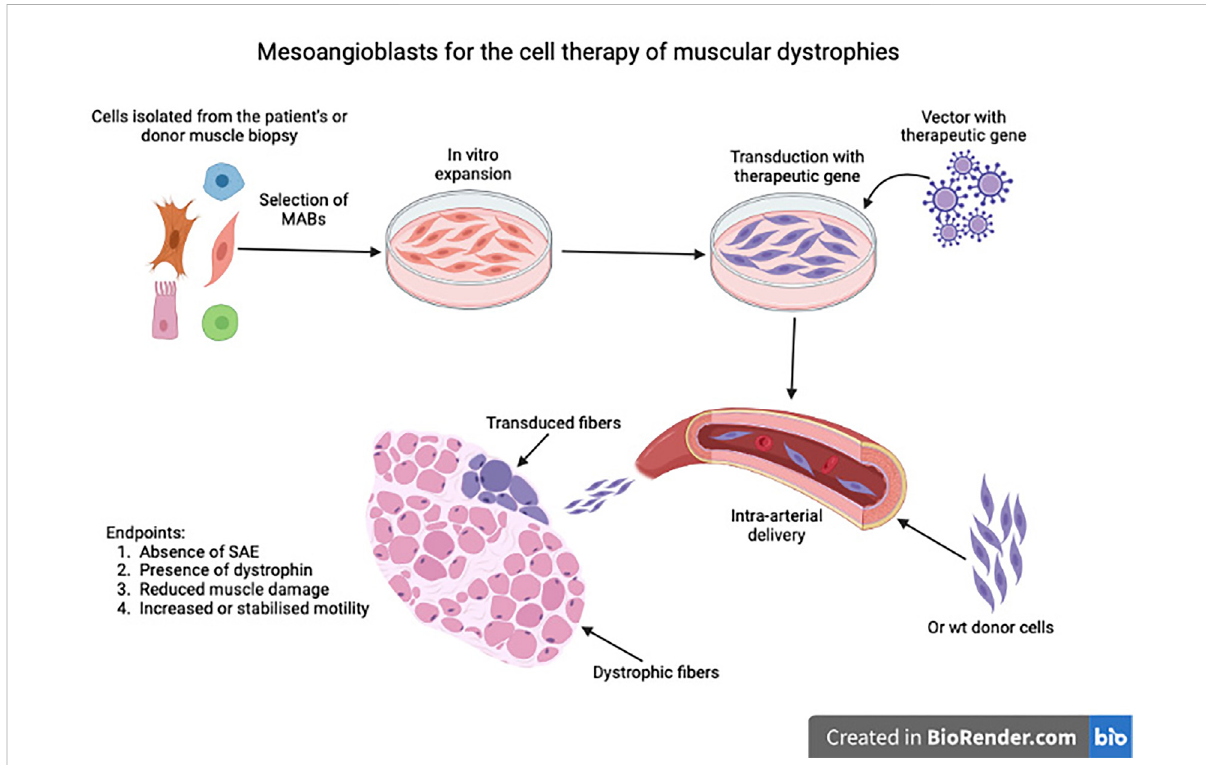
FIGURE 5 Schematic representation of the process leading to isolation, expansion, eventual transduction or mesoangioblasts as Advanced Therapy Medicinal Product (ATMP) and subsequent intra-arterial administration. SAE: Severe Adverse